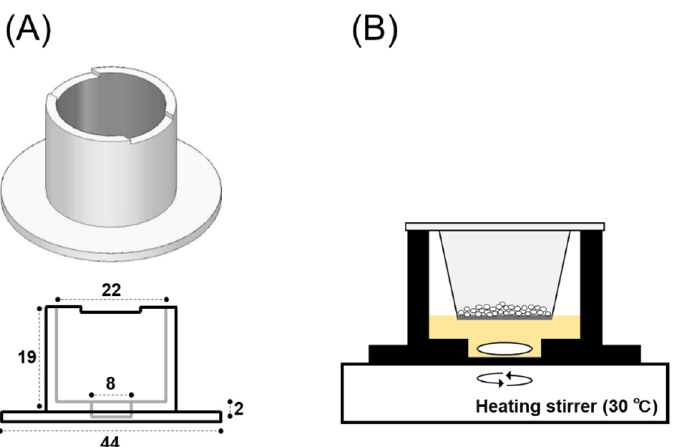
Figure 1. Schematic representation of the in vitro evaluation system on the dissolution of powders. ( A ) The schematic design of the dissolution chamber constructed by 3D printing. The scale is expressed in unit of mm. ( B ) The system for evaluating powder dissolution into the artificial nasal fluid (ANF). The surface area applied powders is 0.9 mm 2 .